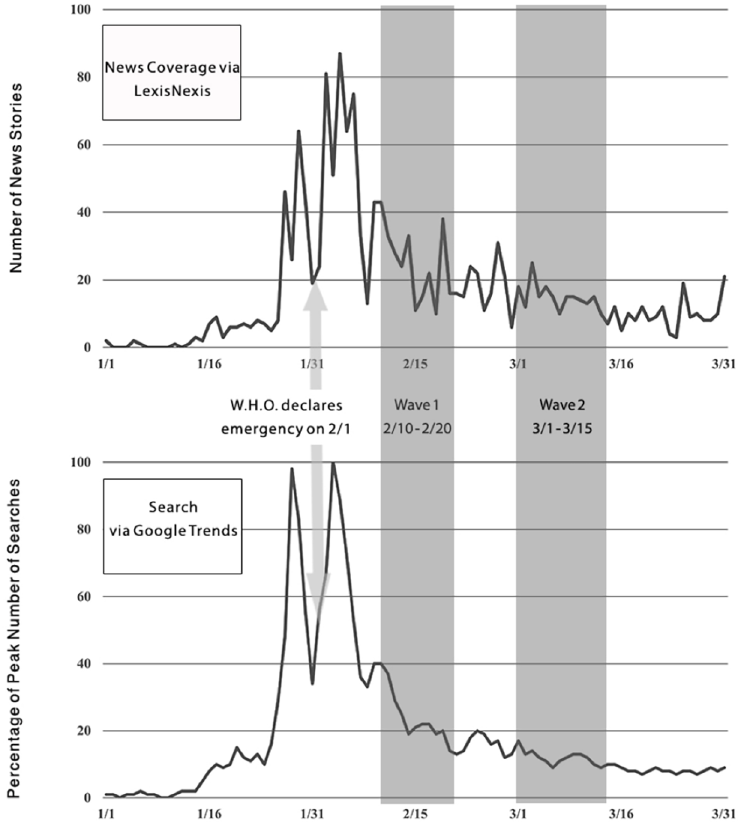
the world. Fig 1 shows the results for the “Zika” in the U.S. during the period January 1 to March 31. Similar to the newspaper data, the Internet search results show spikes of activity just before and after the WHO declaration of